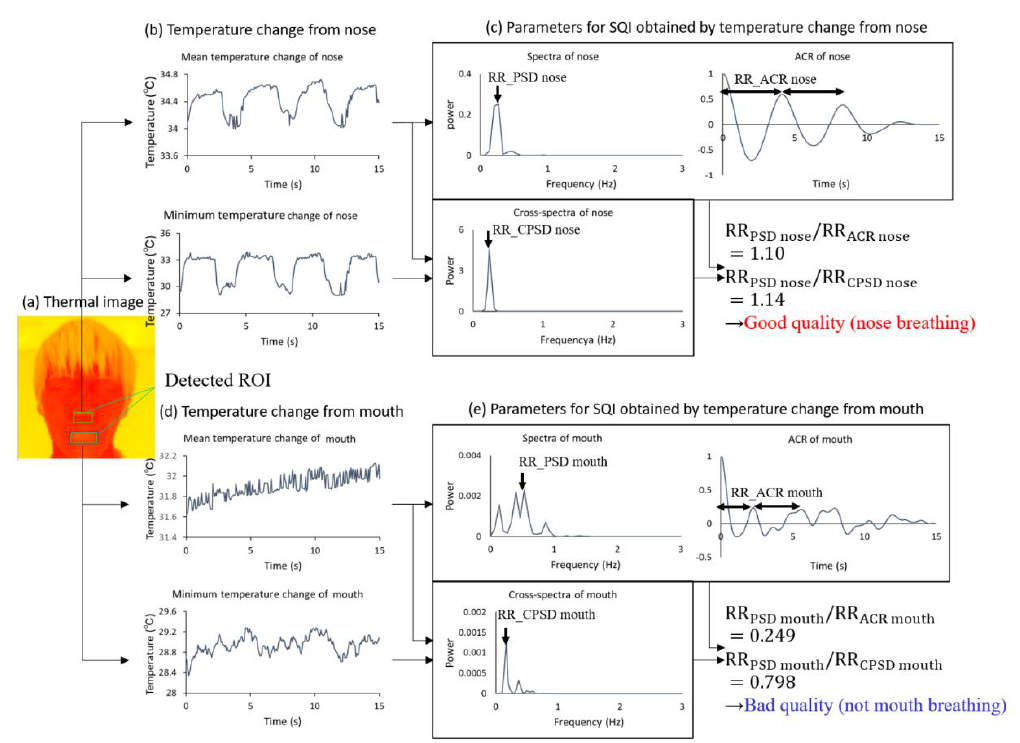
Figure 8. Determination of respiration signal applying nasal and oral breathing decision based on SQI. ( a ) Thermal facial image with ROI. ( b ) Mean and minimum temperature fluctuations in nasal area. ( c ) SQI parameter obtained by power spectral density (PSD), autocorrelation (ACR) and cross-power spectral density (CPSD) of nasal temperature changes. ( d ) Mean and minimum temperature fluctuations in oral area. ( e ) SQI parameter obtained by PSD, ACR and CPSD.